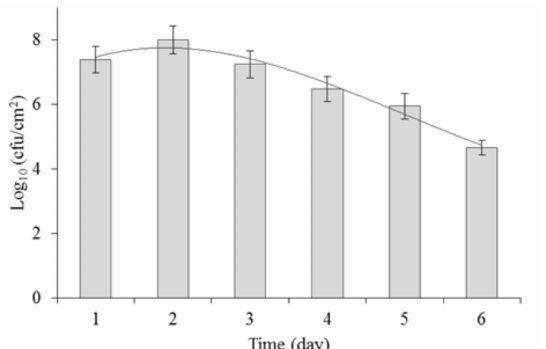
Figure 1. Growth of P. aeruginosa PB_1 biofilm on the surface of polypropylene in 6 days.